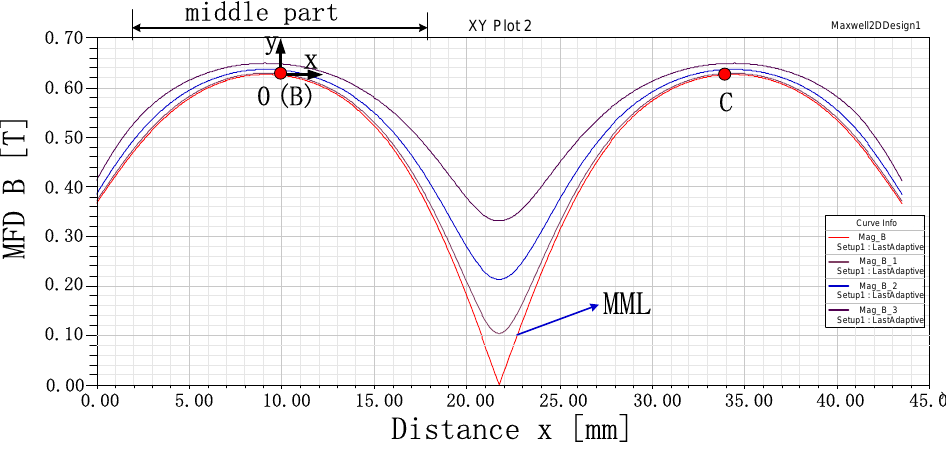
Figure 15. Plot of B